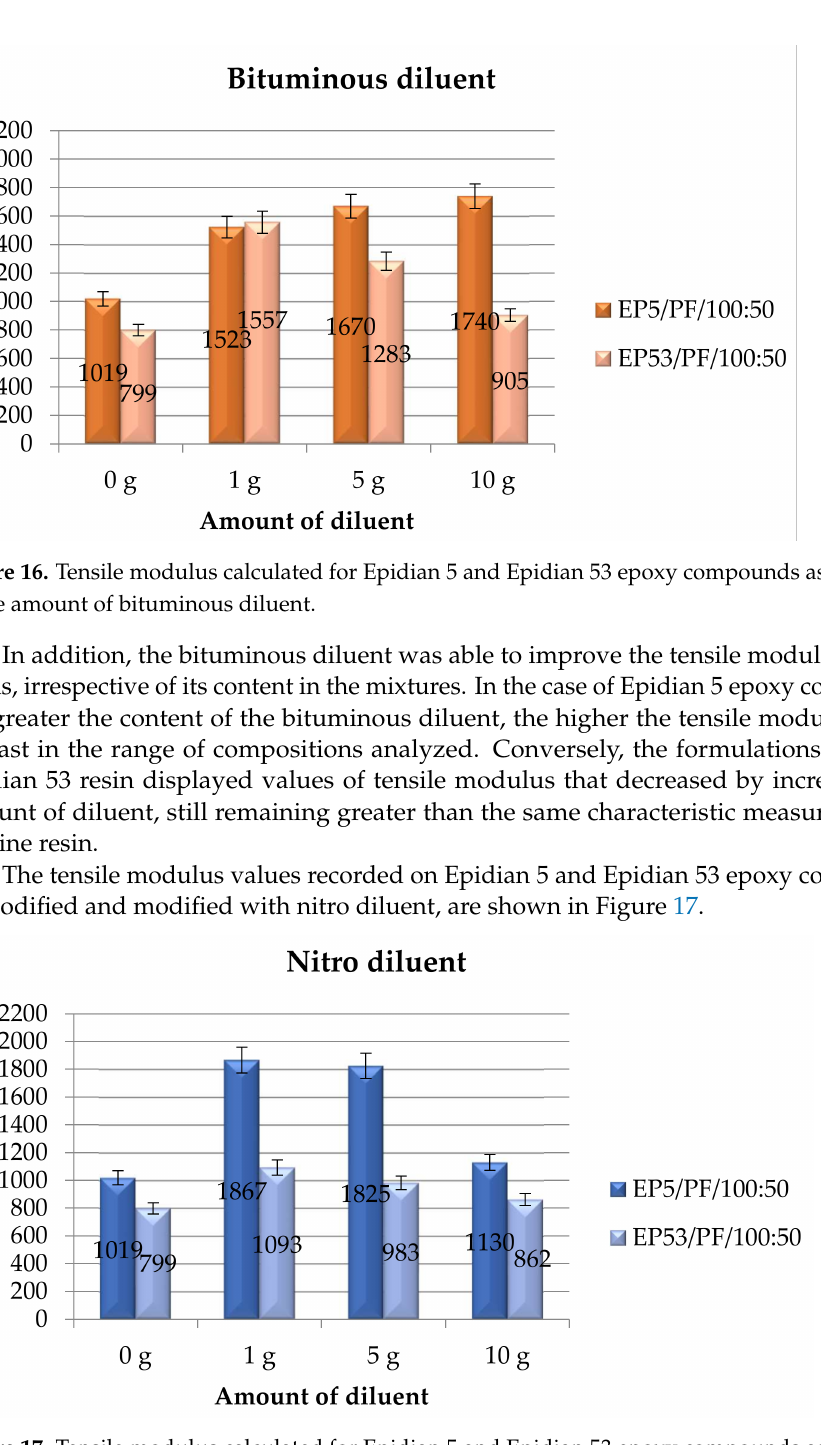
Figure 17. Tensile modulus calculated for Epidian 5 and Epidian 53 epoxy compounds as a function of the amount of nitro